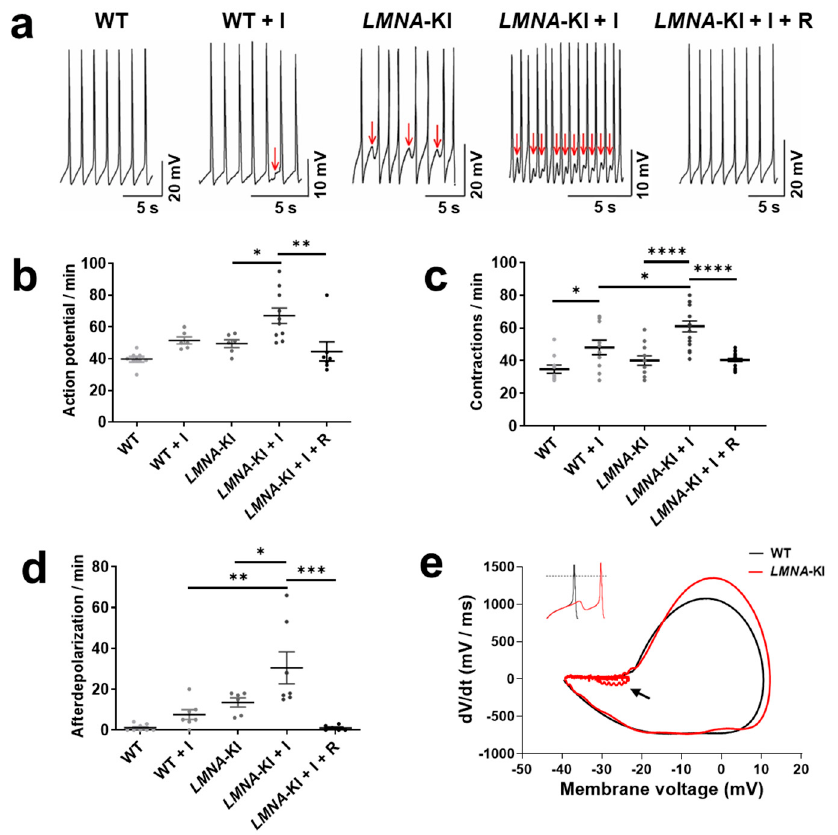
Figure 5. Functional characterization of cardiomyocytes differentiated from WT and LMNA -KI mES cells. ( a ) Electrophysiological recordings of spontaneous APs of WT.CMs, WT.CMs pre-incubated with isoprenaline, LMNA -KI.CMs, and LMNA -KI.CMs pre-incubated with either isoprenaline alone or with isoprenaline and rapamycin; red arrows indicate delayed afterdepolarization-like arrhythmias. ( b – d ) Frequency of APs, contractions, and delayed afterdepolarizations in WT.CM and LMNA -KI.CM under different conditions. ( e ) WT.CM (black line) and LMNA -KI.CM (red line) phase plot (dV/dt versus V) of a single AP; inset shows the respective AP traces (dotted line indicates 0 mV). Arrow indicates the delayed afterdepolarization-like arrhythmias in LMNA -KI.CM. One-way ANOVA and Tukey’s post hoc analysis were used. Data are shown as mean ± SEM (n = 6–19). **** p < 0.0001, *** p < 0.001, ** p < 0.01, * p < 0.05. I = isoprenaline, R = rapamycin, dV/dt = rate of action potential.